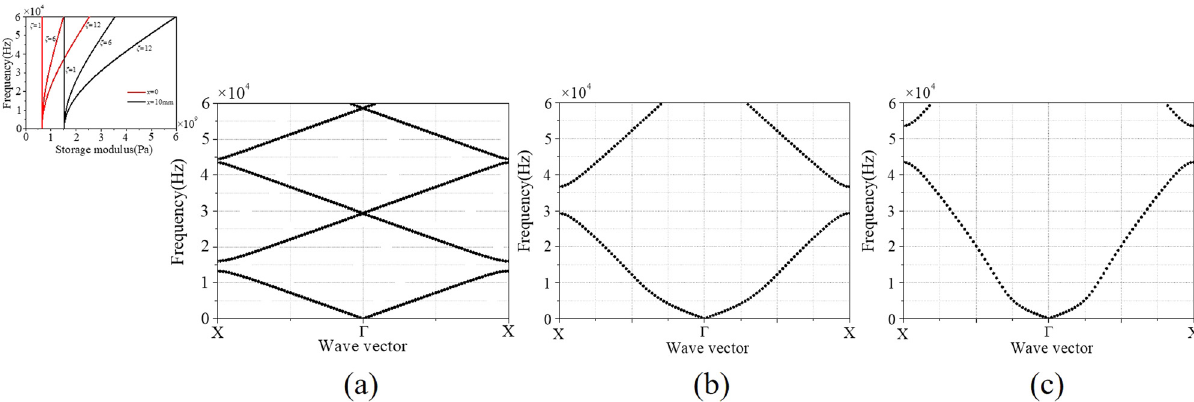
Figure 5: Band gaps of normal incident SH - waves propagating in materials with di ff erent values of viscosity: ( a ) ζ = 1, ( b ) ζ = 6, and ( c ) ζ =